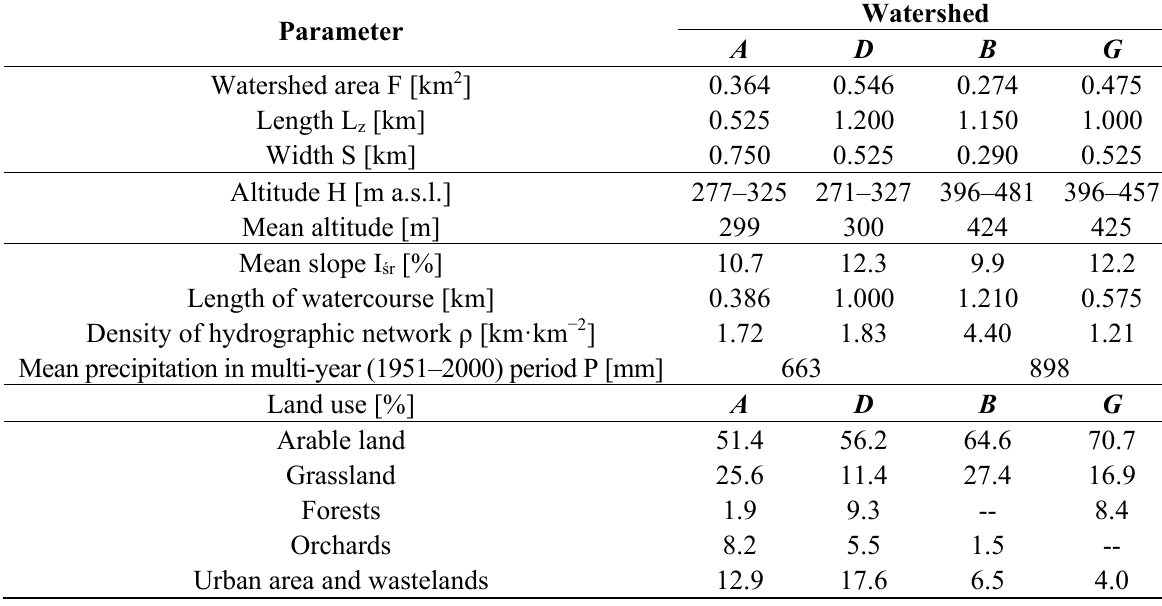
Table 1. Basic physiographic and use-related characteristics of the investigated